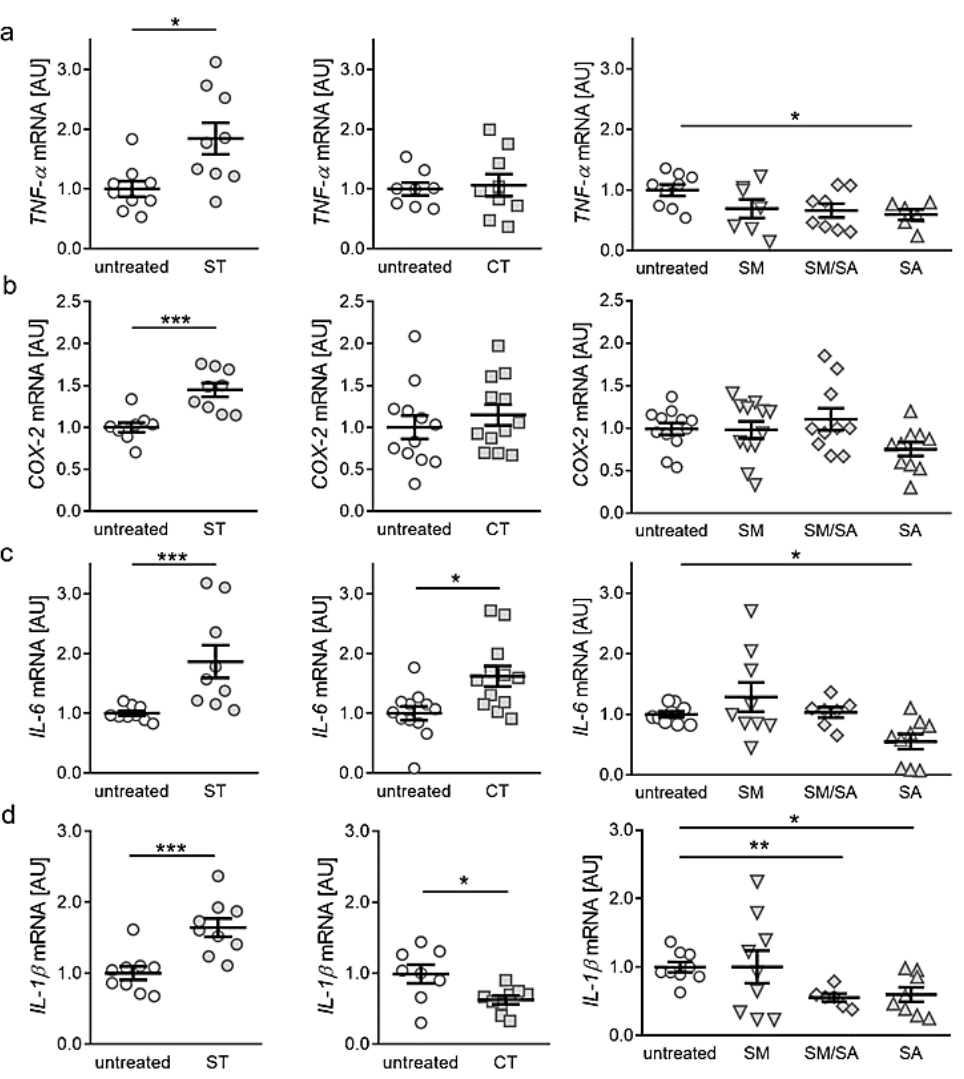
Figure 3. Expression profiles for proinflammatory genes TNF- α ( a ), COX-2 ( b ), IL-6 ( c ) and IL-1ß ( d ) after application of different tensile strain protocols (explanation see manuscript text). AU: arbitrary units, error bars represent standard error of the mean. n > 6; Statistics: ST/CT: Mann-Whitney-U tests; SM, SM/SA, SA: Welch-corrected ANOVA with Games-Howell posthoc tests; * p < 0.05, ** p < 0.01*** p < 0.001.